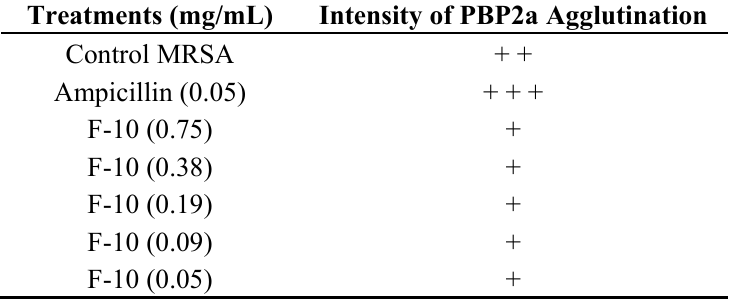
Table 1. Semi-quantitative estimation of PBP2a occurrence in biofilms isolated from different treatments. Intensity of agglutination against a turbid background was observed and scored between + to + + +, where the control latex which showed no reactivity in the absence of PBP2a is considered as “−” (interpretation: + + + high, + + moderate, + low, n =